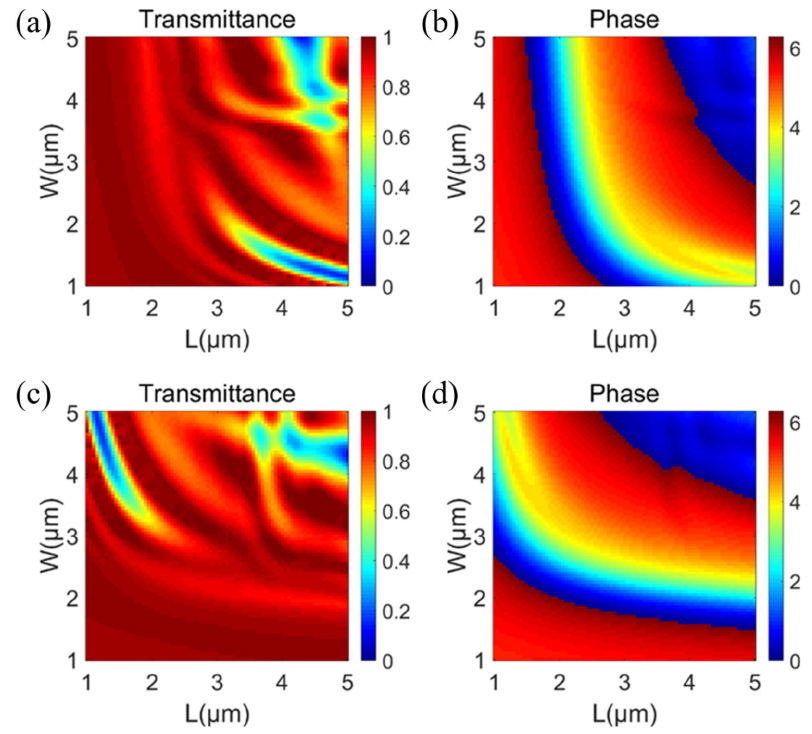
Figure 3. The relationship between the transmittance and the length and width of the nanorods: ( a ) X − polarized light; ( c ) Y − polarized light. The relationship between the propagation phase and the length and width of the nanorods: ( b ) X − polarized light; ( d ) Y − polarized